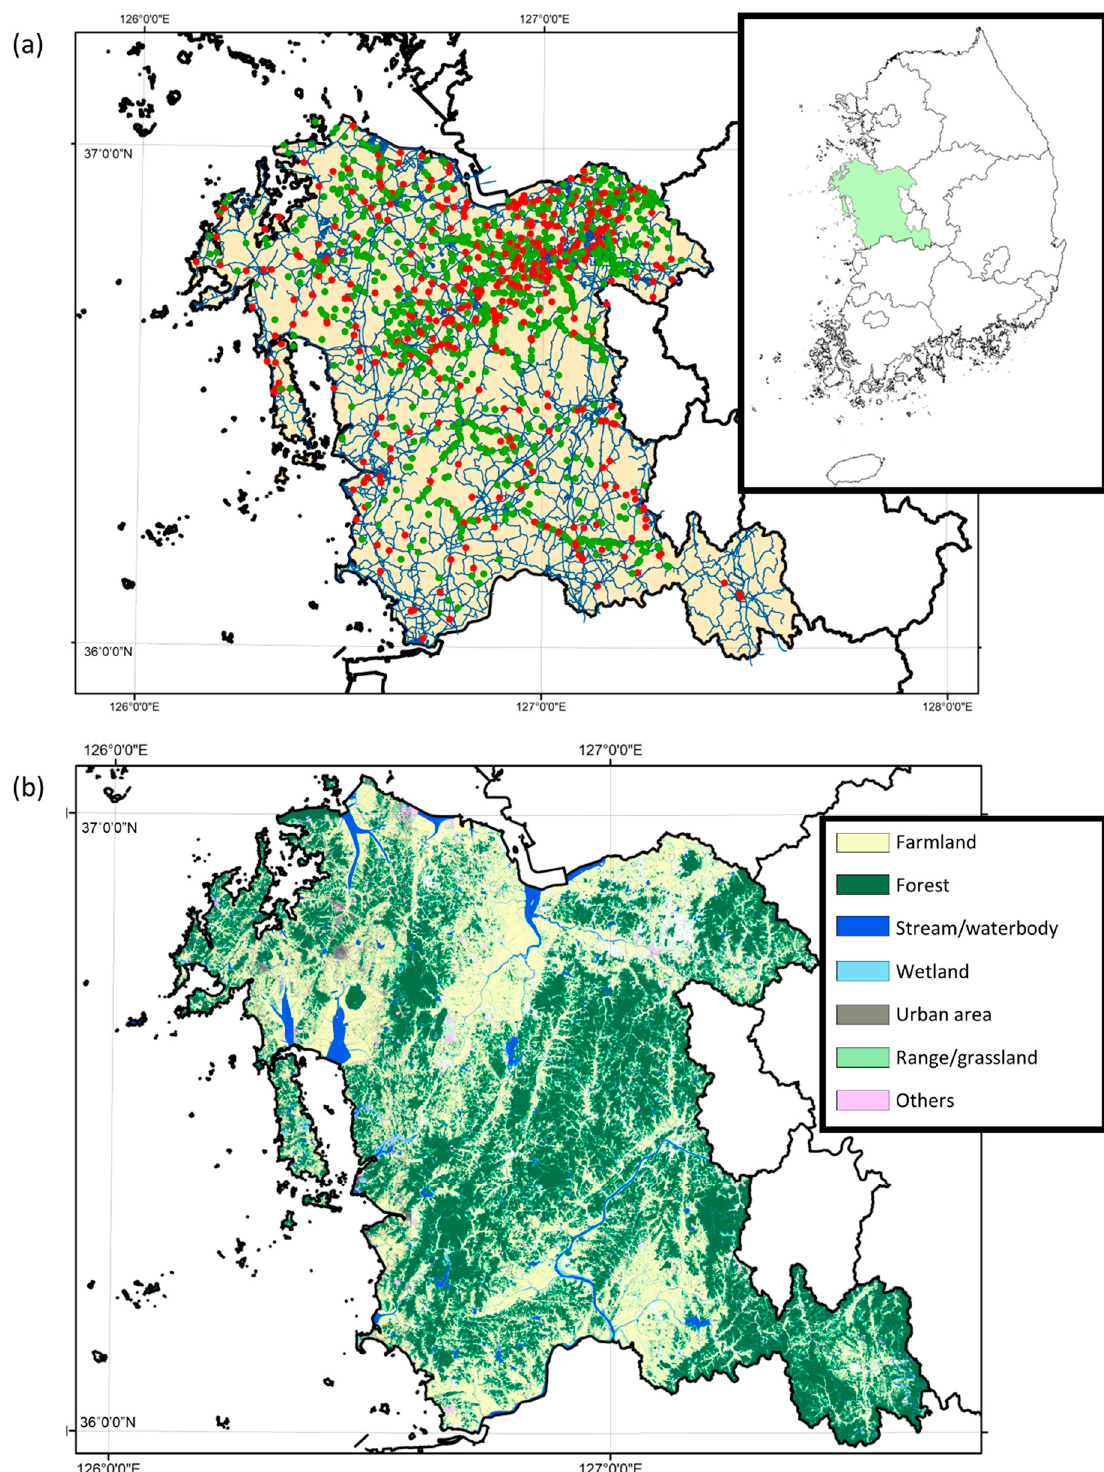
Figure 1. ( a ) Study area and locations of roadkills and ( b ) land use of the Province of Chungcheong- nam. In panel ( a ), blue lines indicate the road networks and red and green dots represent water deer and other roadkills, respectively.